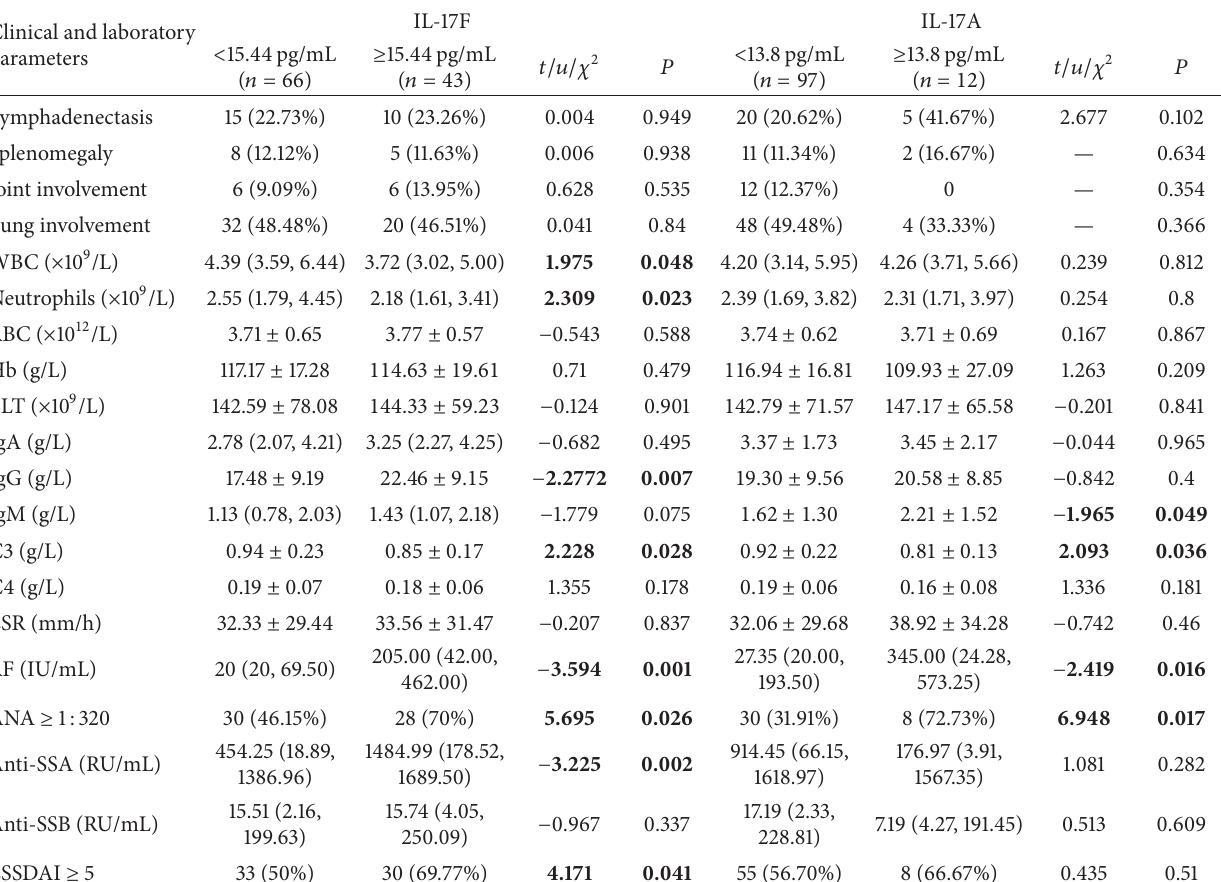
Table 3: Clinical and laboratory characteristics of pSS patients with the elevated and normal levels of serum IL-17F and IL-17A. Clinical and